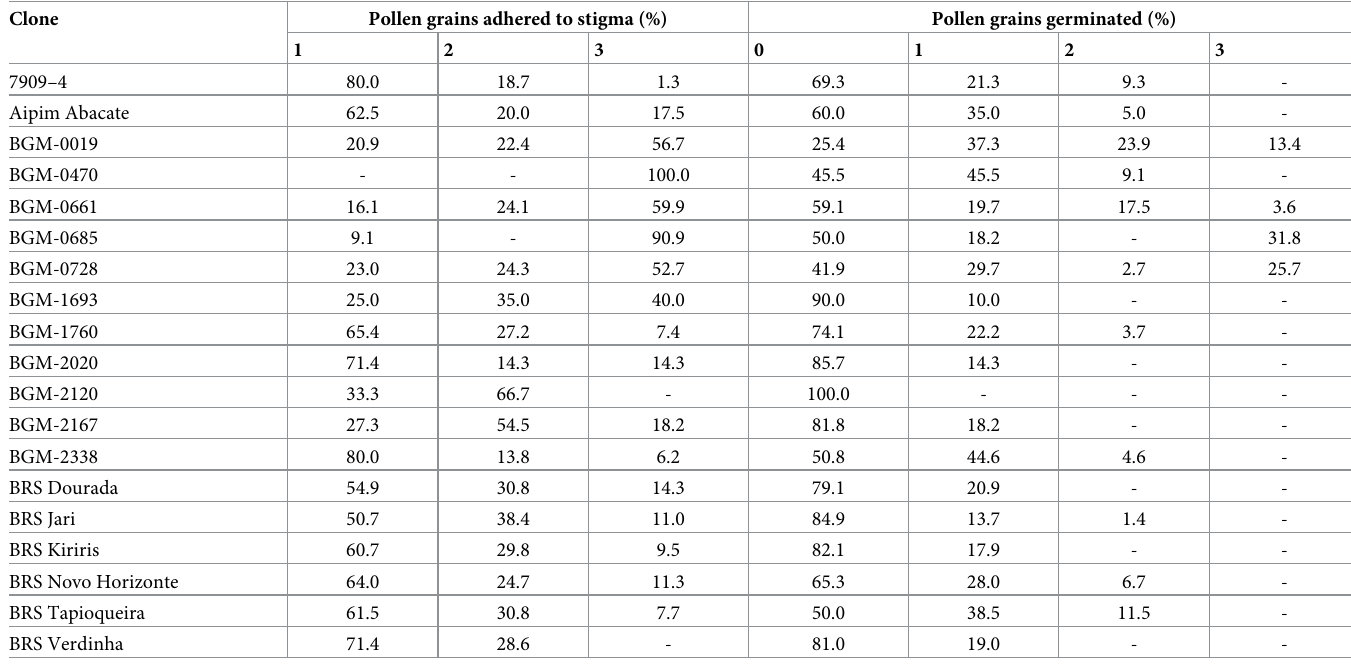
Table 3. Observed frequencies of pollen grains adhered to the stigma and germinated in different cassava genotypes used as male parents in Experiment 2. Clone Pollen grains adhered to stigma (%)